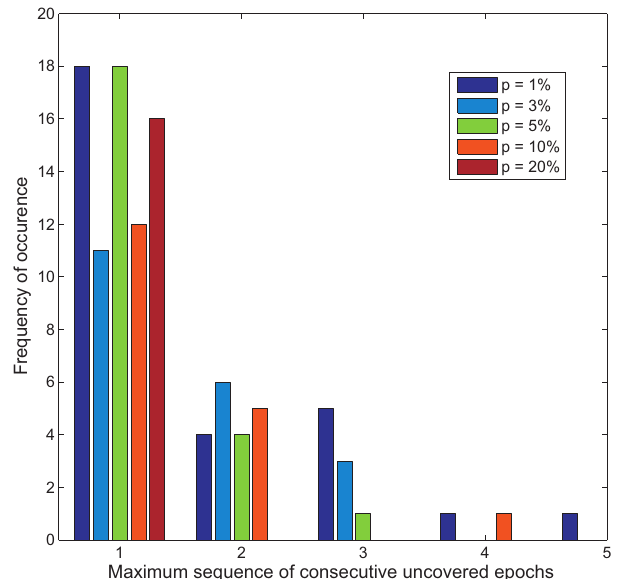
Figure 8. Histogram showing spread of maximum sequence of consecutive uncovered epochs when combining schedules of adjacent nodes using randomized scheme for differ- ent values of p